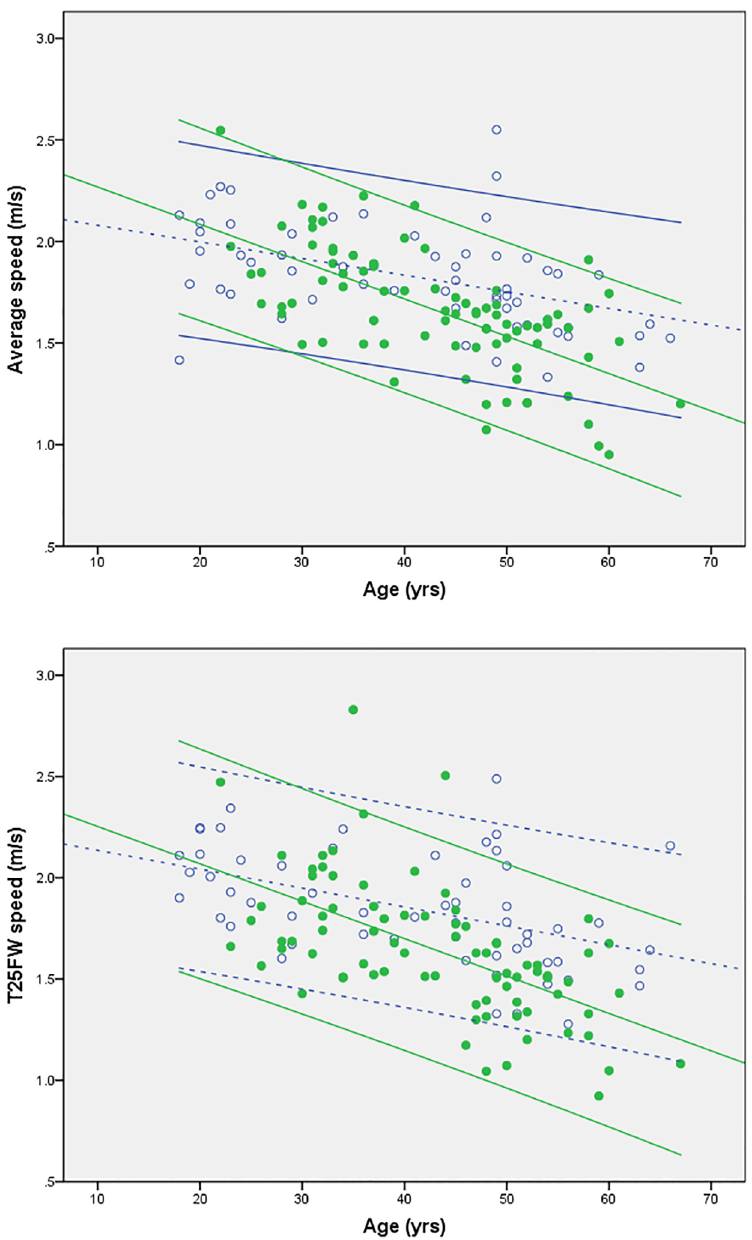
Fig 2. Univariate regression of maximum walking speed assessedwith SMSW (averagespeed (A)) or T25FW (B) and with age as factor in HC (open circles, dashed lines) and PwMS (filled circles, continuous lines). Regression lines are given along with their 95%